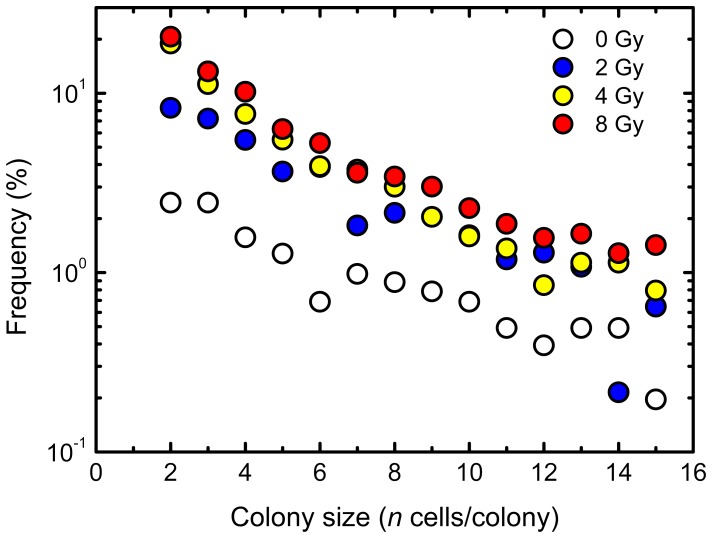
Empirical colony size distribution.Circles indicate the experimentally determined data at 0, 2, 4 and 8 Gy of 60Co γ-rays. “Frequency” represents the frequency of a colony with n cells in all abortive and clonogenic colonies.